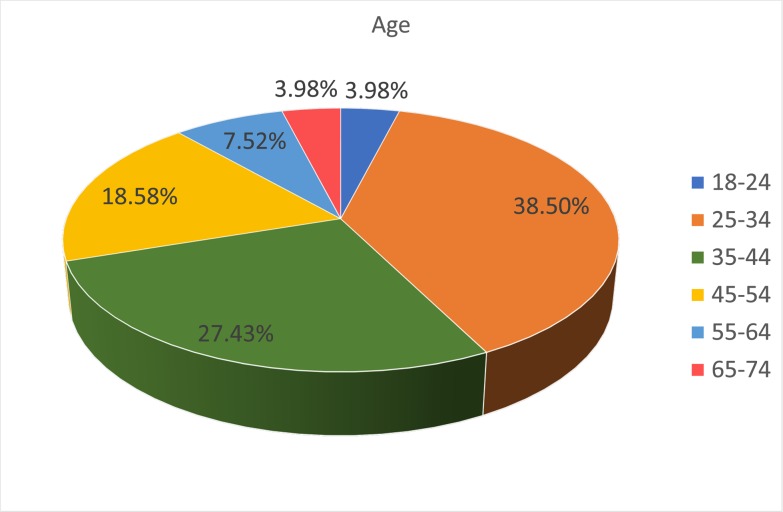
Age of respondents.